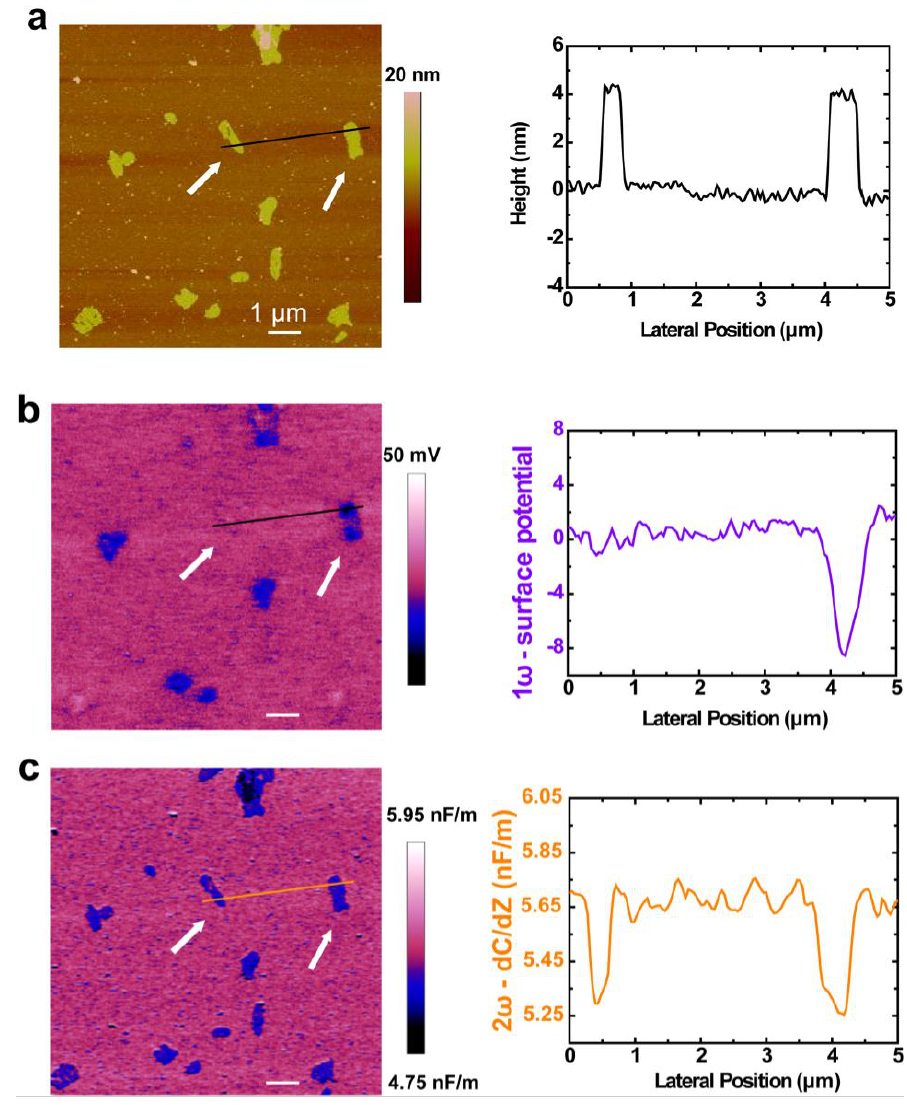
Figure 3. Nanoscale electric imaging of PM on silicon. ( a ) Topography; ( b ) Surface potential image; ( c ) Dielectric capacity derivative image. The line profiles at selected lines as indicated in the images are shown in the corresponding line plots.